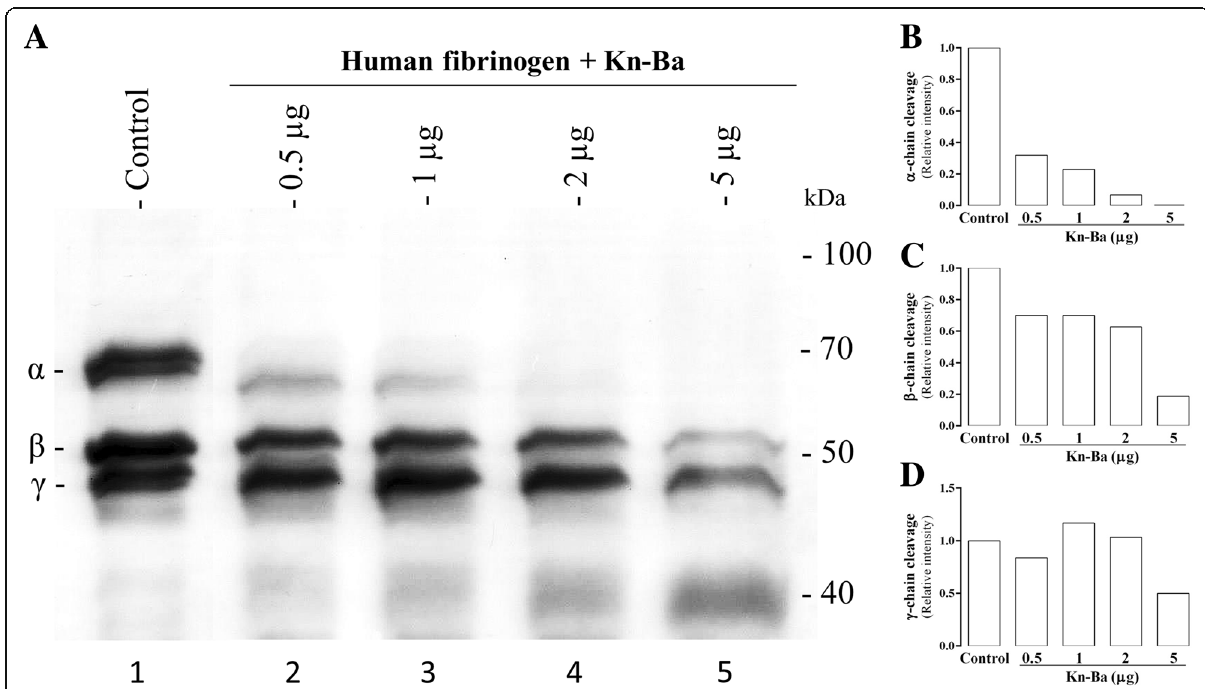
Fig. 5 Human fibrinogen cleavage. a Coomassie-stained-SDS-PAGE (10%) analysis of the human fibrinogen pre-incubated with 0.5 – 5 μ g of Kn-Ba. The relative intensities of the bands were estimated by densitometry: b α -chain, c β -chain, and ( d ) γ -chain cleavage